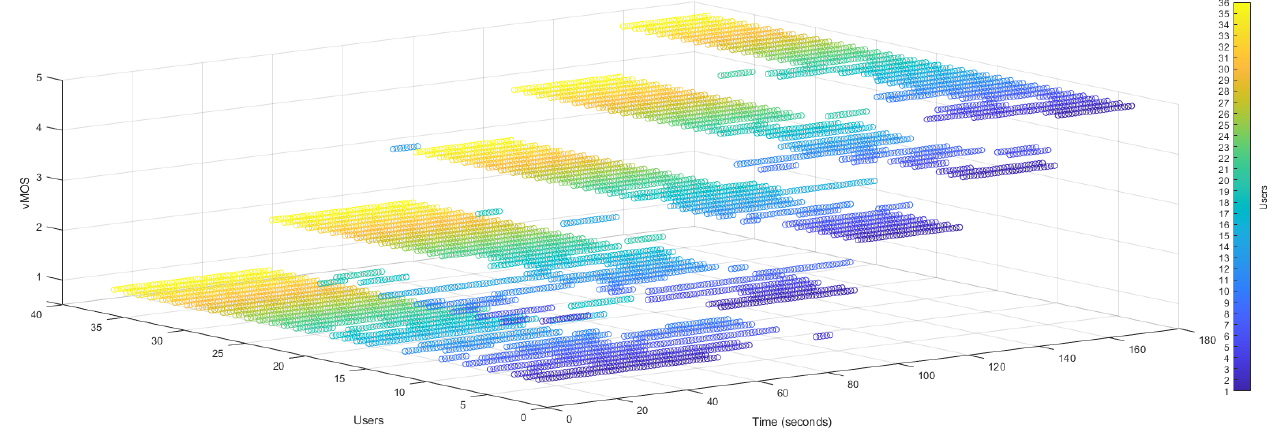
Figure 8. Results of vMOS experimentation